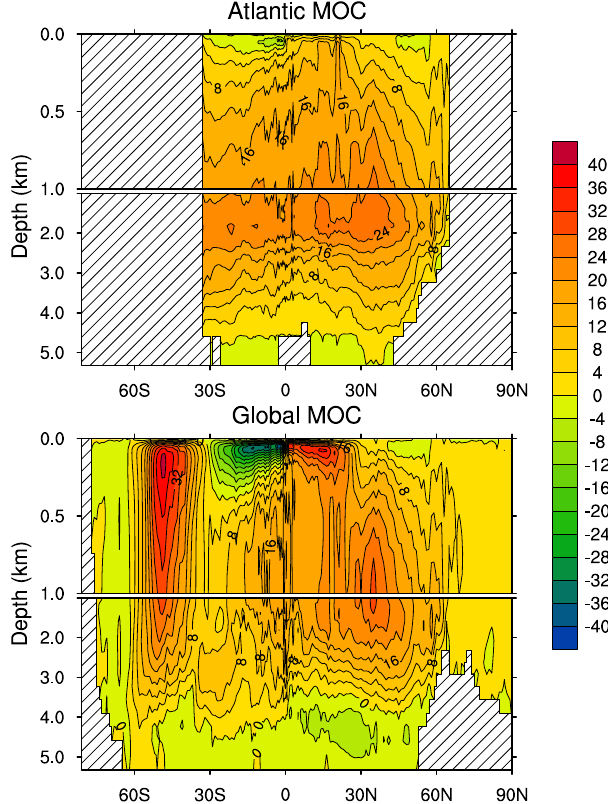
Figure 13. Atlantic meridional overturning circulation (MOC) (Sv) and global MOC (Sv) for the period 1976–2005 from the BNU- ESM historical